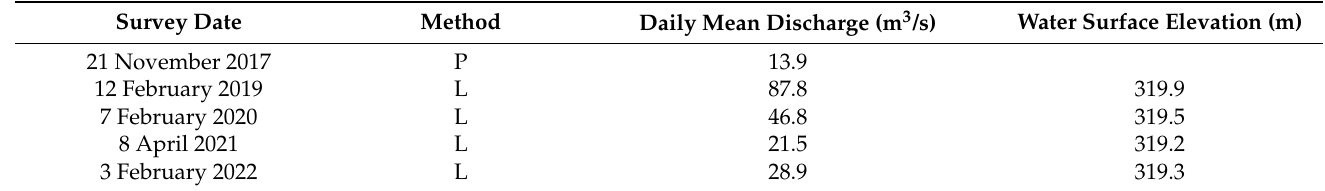
Table 4. Dates, daily mean discharges at the Vic-le-Comte gauging station (“https://hydro.eaufrance. fr (accessed on 15 February 2023)”), and water surface elevations at the bank for all survey campaigns at Site 1, which permitted us to calculate the erosion rates of the restored bank. (P) Photogrammetry; (L) LiDAR.